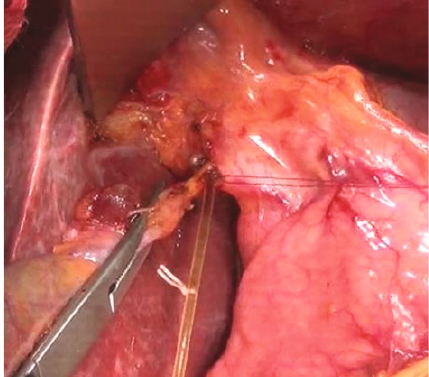
Figure 1: Cholecystectomy and inserting a catheter into main bile duct through cystic